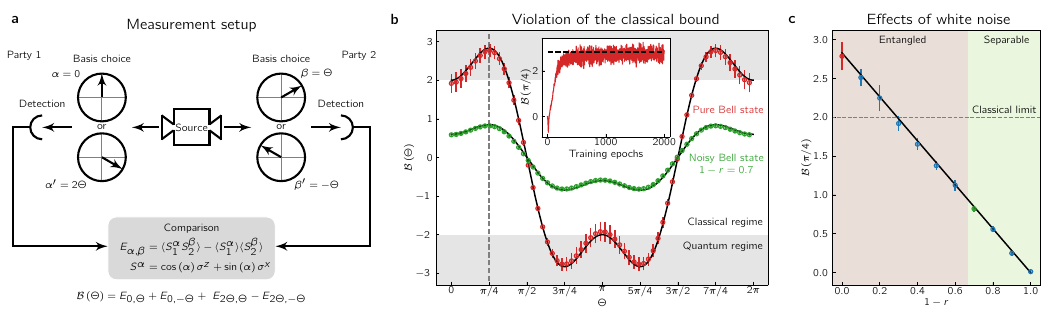
Figure 2: Encoding Bell states and Werner states. a , Illustration of a typical Bell- test scenario. Two correlated qubits emerging from a source are distributed between two parties. Each of the parties is allowed to choose between two different measure- ments each characterized by a single common angle Θ . The measurement outcomes indicate genuine quantum correlations if the combination B ( Θ ) of the correlations violates the inequality | B ( Θ ) | ≤ 2 obeyed by classical states. b , Observable B ( Θ ) = | Ψ + 〉〈 Ψ + | on the neuromor- evaluated on the learned encoding of the Bell state ρ B phic hardware, with M = 20 hidden neurons. Red symbols depict the observable for different angles Θ , averaged over the last 200 training epochs, where errorbars here and in the following denote the standard deviation. Note that these data points have been obtained from the same trained network and the same set of neuron states sampled from it by evaluating the observable for different angles Θ on this sample = r ρ + ( 1 − r ) (cid:49) / 4 are obtained by adding white noise to the set. Werner states ρ W B pure Bell state. Green points correspond to r = 0.3. In both cases, the data capture the exact values (black lines) well, including the violation of the classical bound in the pure case r = 1. The inset shows the evolution of the Bell-correlation witness B ( Θ = π/ 4 ) during training (red line) and the convergence towards the expected value (black dashed line). c , Bell-correlation witness B ( Θ = π/ 4 ) for a Werner state as a function of the noise strength 1 − r . The exact solution (black line) is captured well for both entangled and separable